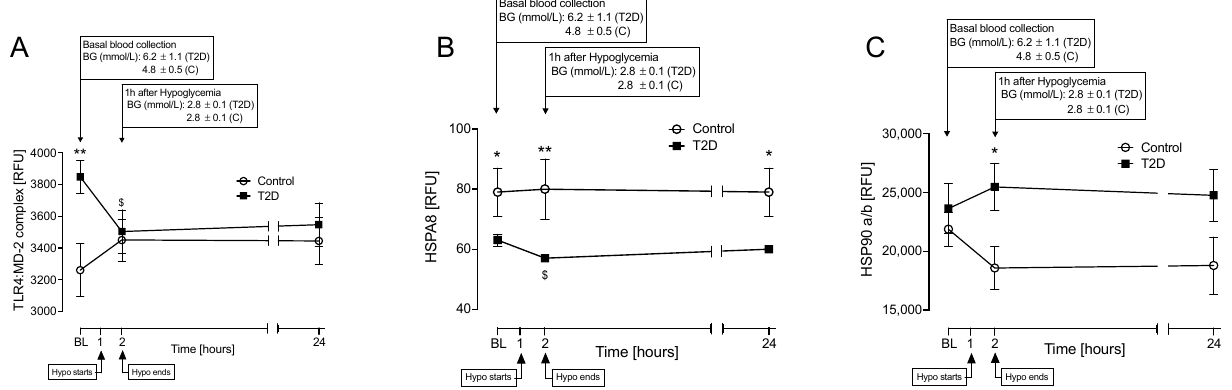
Figure 2. Comparison of plasma levels of the following heat shock proteins: toll-like receptor 4:myeloid differentiation factor-2 (TLR4:MD-2), heat shock protein family A (HSP70) member 8 (HSPA8), and heat shock protein 90 dimer (HSP90a/b) at baseline (BL), at hypoglycemia and 24 h post-hypoglycemia in control and T2D cohorts. Controls (white circles), T2D (black squares). TLR4:MD-2 ( A ), HSPA8 ( B ), and HSP90a/b ( C ). Panels ( A , B ) show proteins for which levels differed at BL between T2D and control cohorts. Statistics: *, p < 0.05; **, p < 0.01, control vs. T2D; $, p < 0.05, T2D BL vs. Hypo. RFU, relative fluorescent units; Hypo, hypoglycemia.